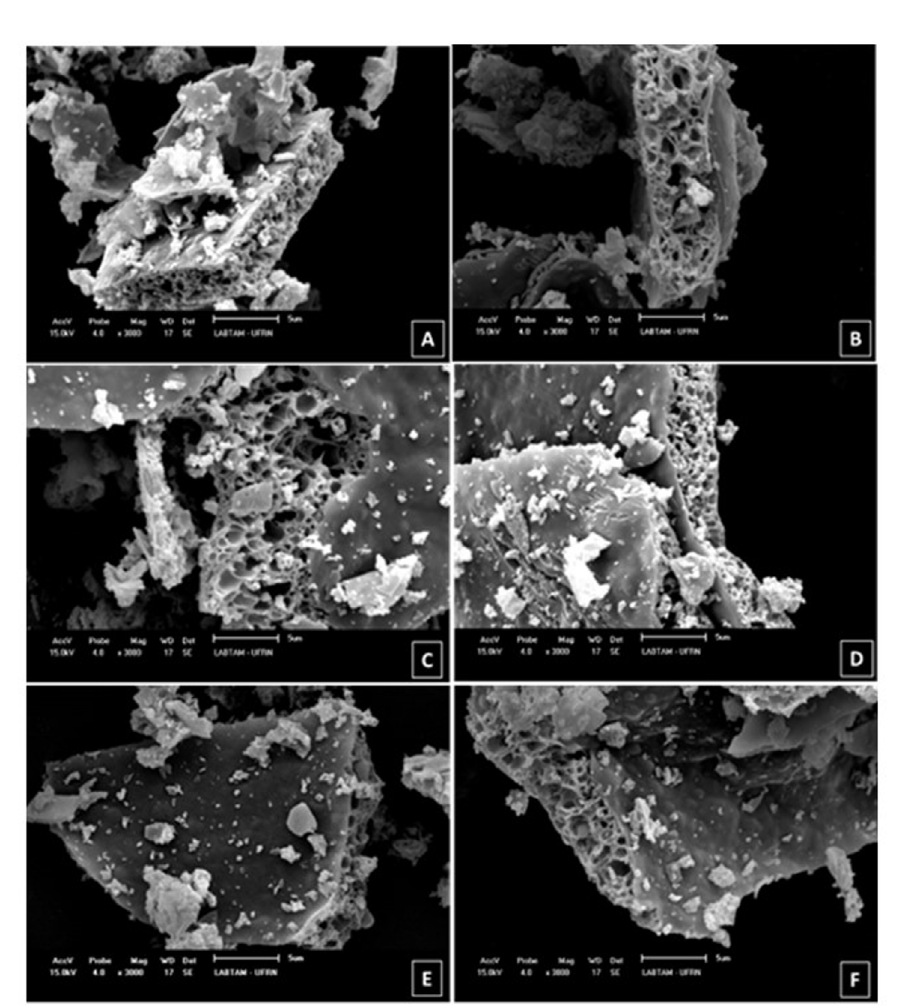
O . A) 700 ºC/2 h, B) 700 ºC/4 h, C) 900 ºC/2 h, D) 900 ºC/4 h, E) 1100 ºC/2 2 4